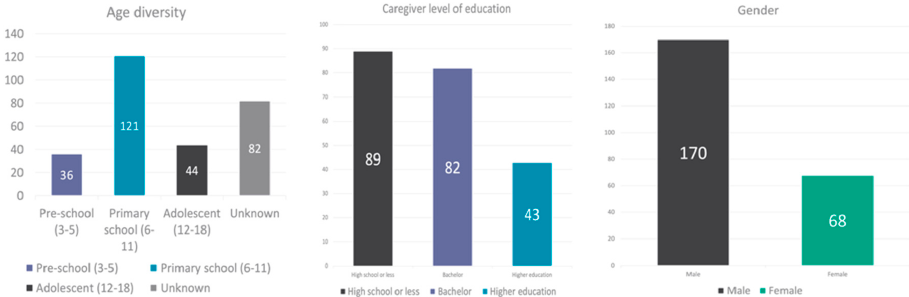
Figure 1. Demographic characteristics of children, and parents’ source of information for the diagnosis of attention deficit hyperactivity disorder (ADHD).